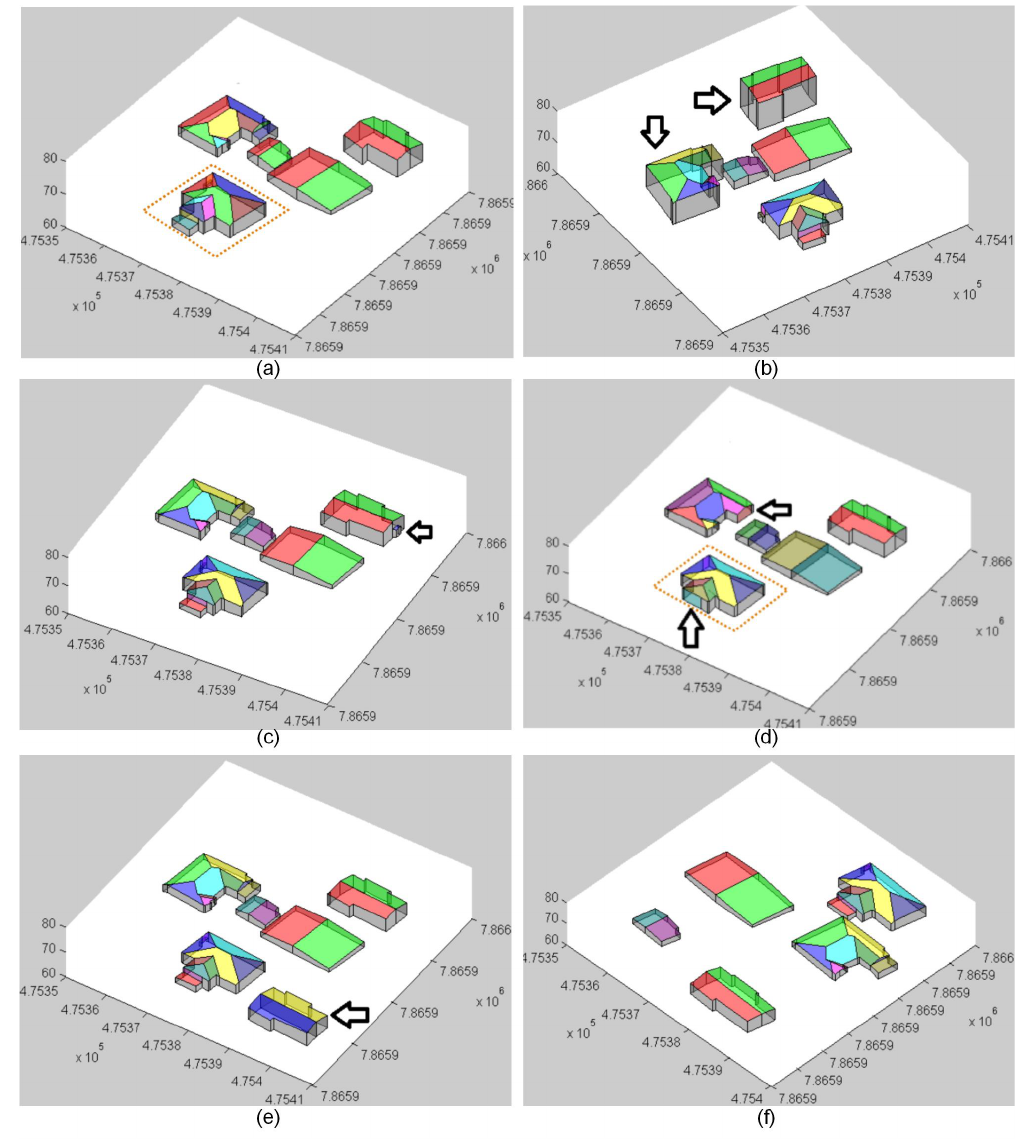
Figure 10. Introduction of five different changes: ( a ) reference data; ( b ) addition of height to buildings; ( c ) addition of a veranda; ( d ) removal of verandas; ( e ) addition of a new building; and ( f ) relocation of building